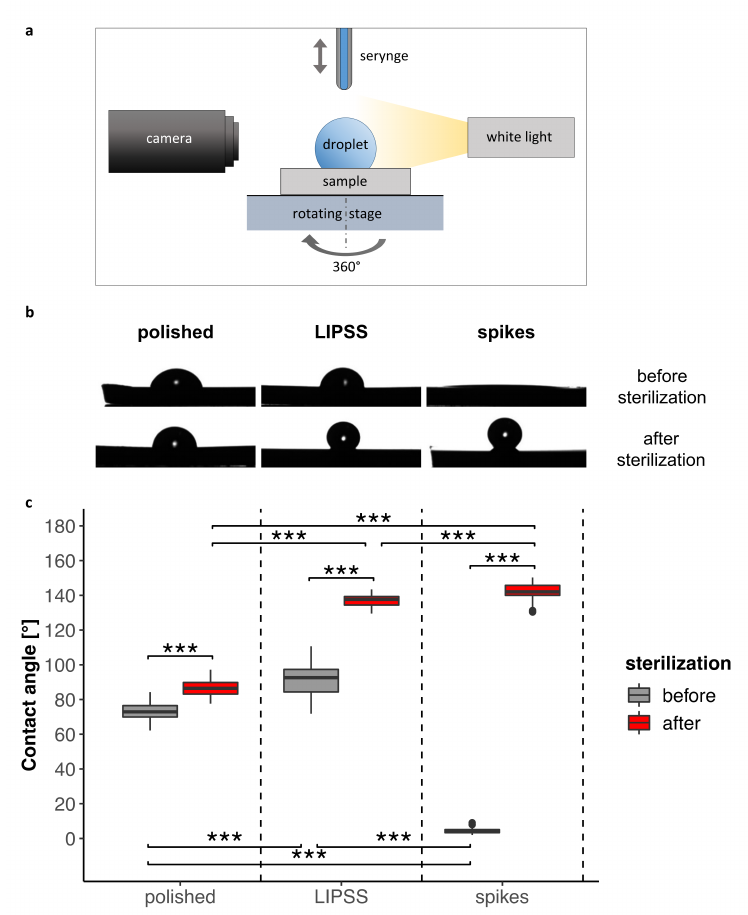
Figure 2. Comparison of the contact angles on polished and laser-nanostructured surfaces before and after sterilization. ( a ) Schematic of experimental setup for wettability characterization. ( b ) Representative droplet profile according to surfaces and sterilization process ( c ) 360 ◦ measurements from four consecutive droplets (at least 200 measurements per boxplot) of culture medium (2 µ L) deposited on each surface (one sample). The Kruskal–Wallis test followed by Mann–Whitney pairwise comparison with Bonferroni correction was performed for data before and after sample sterilization. *** p -value <